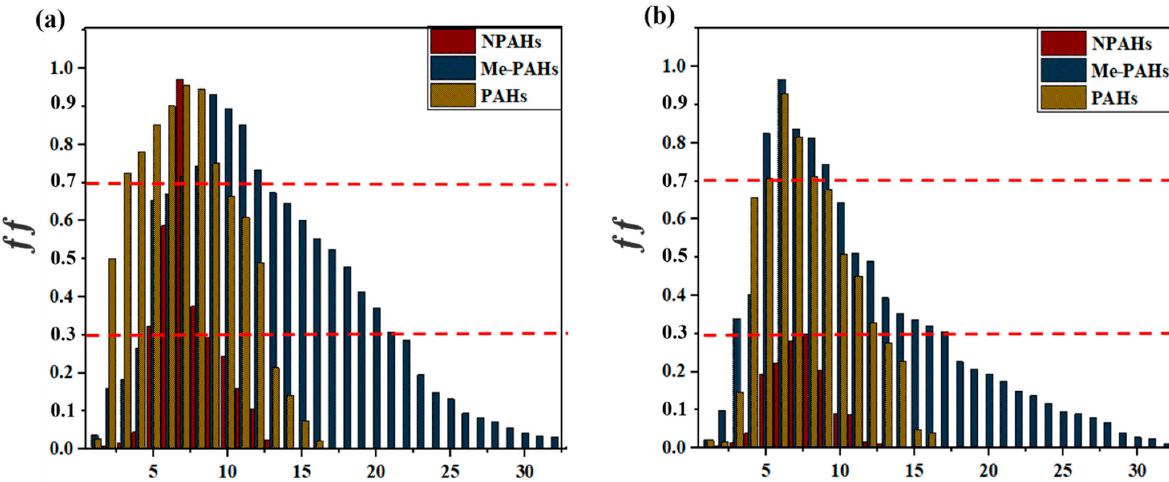
Figure 3. Fugacity of the fraction ( ff ) between river water and sediment in Songhua River in ( a ) summer and ( b ) winter.